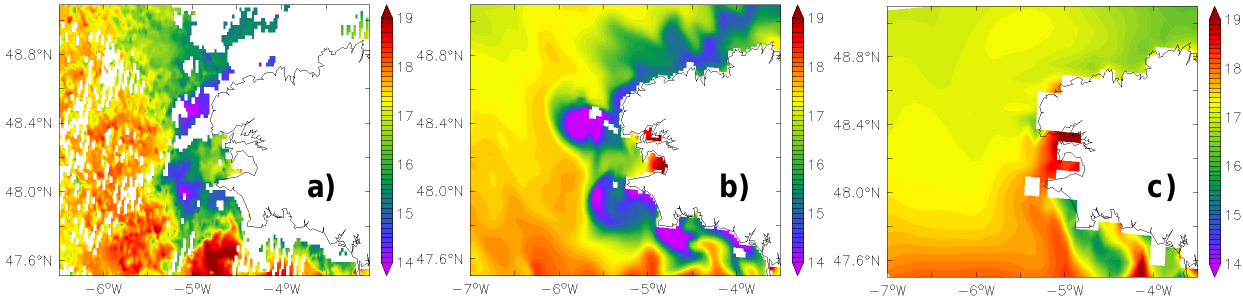
Figure 10 : Ushant front off French Britain coast (07/09/2011) a) MF_CMS SST; b) V2 system SST; c) V1 system SST. Table 4. Spatial average (observation minus model) Sea Surface Temperature difference ( ◦ C) (left), correlation (middle) and RMS (observation minus model) SST error ( ◦ C) (right) for the period May–June 2009 in the different regions presented in Fig. 7. Best scores are in bold. We subtracted the linear trend of the time series before calculating the